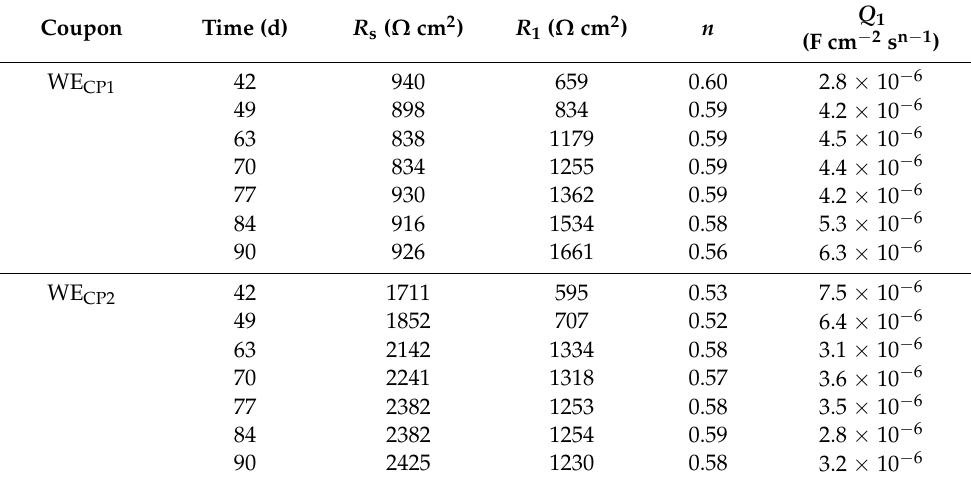
Table 3. Fitted values of EIS data for coupons WE CP1 and WE CP2 under